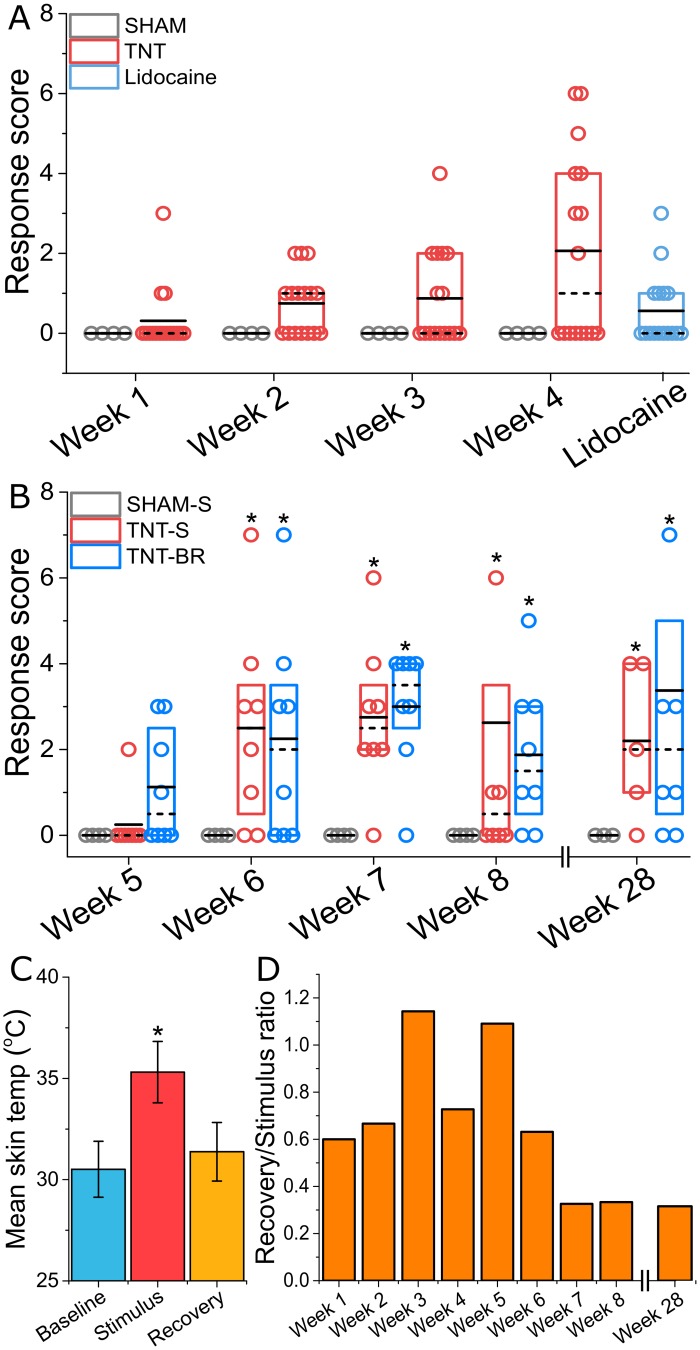
Thermal stimulus elicits post-neurotomy pain.(A) Hollow circles indicate the summed behavioral response score for each animal for both TNT (red) and SHAM (grey) groups. Statistically significant mean pain response scores (solid black line) were observed between TNT and SHAM groups in week 4 and in weeks 6–8, following bulb resection (B). Lidocaine was found to be a successful moderator of heat-induced neuroma pain. Dashed black lines indicate population median. (B) Following bulb resection surgery, significant heat-induced neuroma pain persisted from week 6 until week 28. No statistically significant difference was found between animals receiving bulb resections vs TNT-SHAM animals. For statistical comparisons between groups, a two-tailed Mann-Whitney test was used (* p<0.05, ** p<0.01). (C) Thermal stimulus exposure induces a significant mean skin temperature increase. A mean skin temperature increase of approximately 5°C was observed following 5 minutes of heat-lamp exposure. (D) Recovery-to-Stimulus behavioral response ratios for all time points.